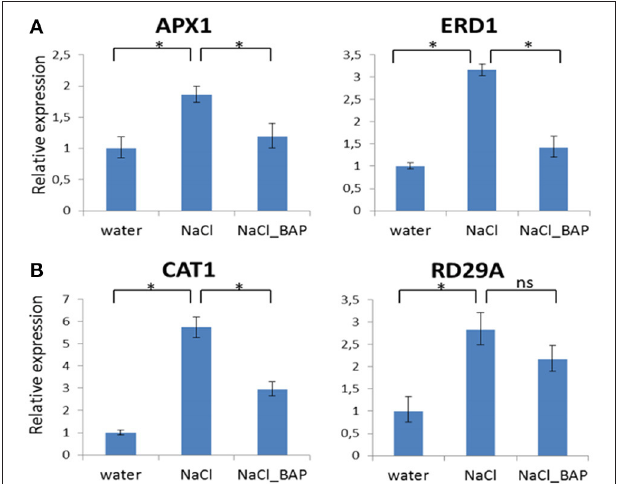
FIGURE 3 | Effect of CK on relative expression of the APX1, ERD1 (A), and CAT1, RD29A (B) genes in Arabidopsis plants under salinity stress. Arabidopsis w.t. plants were grown for 30 days in optimal conditions and then leaves were detached and exposed to salinity stress of 100mM NaCl or salinity plus 10 µ m CK (BAP) for 24h. Controls were detached leaves in water treatment. Samples (3 for each treatment) were collected from control and stressed leaves. Relative expression was measured by qRT- PCR. Expression of each gene in w.t. control plants was used for comparison (relative expression = 1). Horizontal brackets denote significance of P < 0.05 (*, statistical significance; ns, no significance).